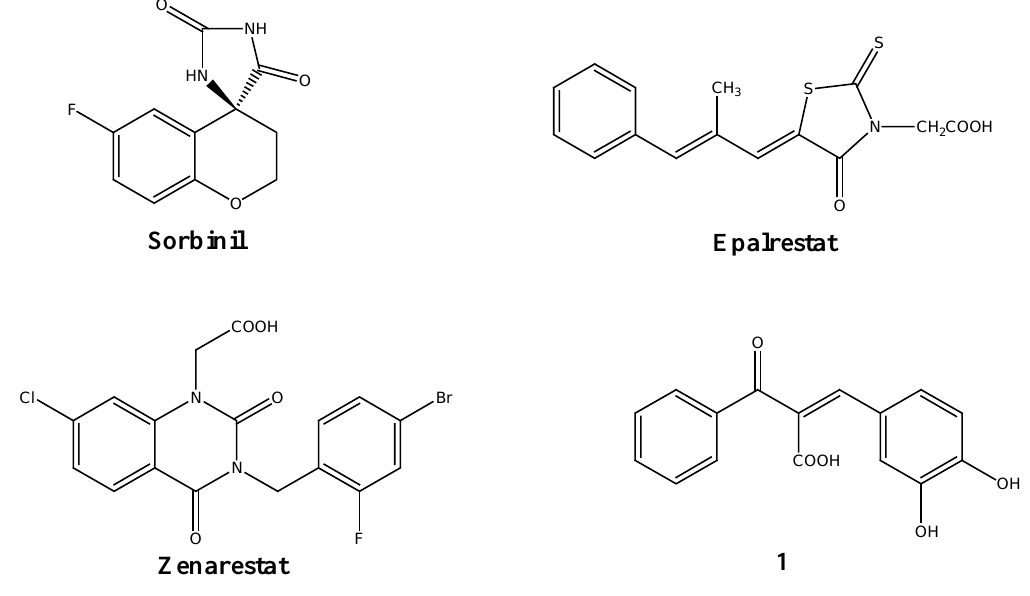
Figure 1. Potential aldose reductase